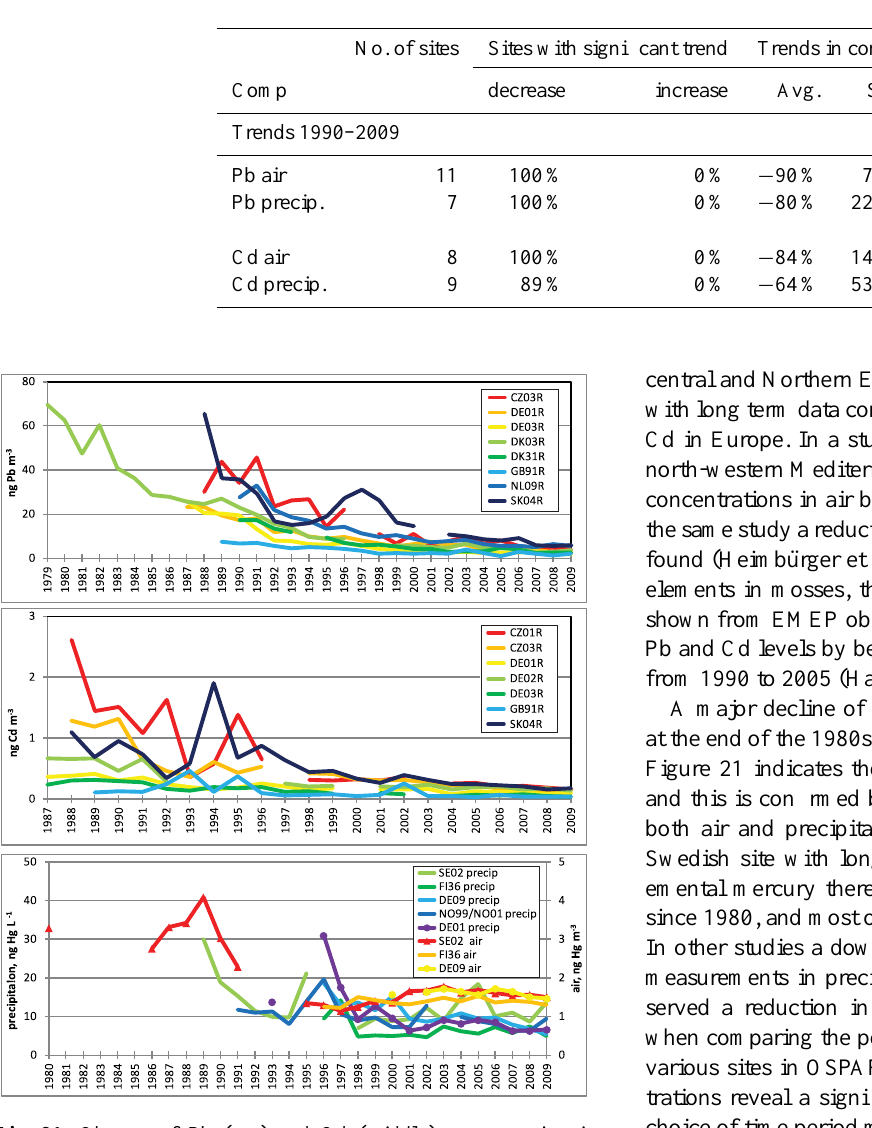
Table 6. Change in Cd and Pb concentrations in air and precipitation, compared to emission changes from 1990 through 2009.